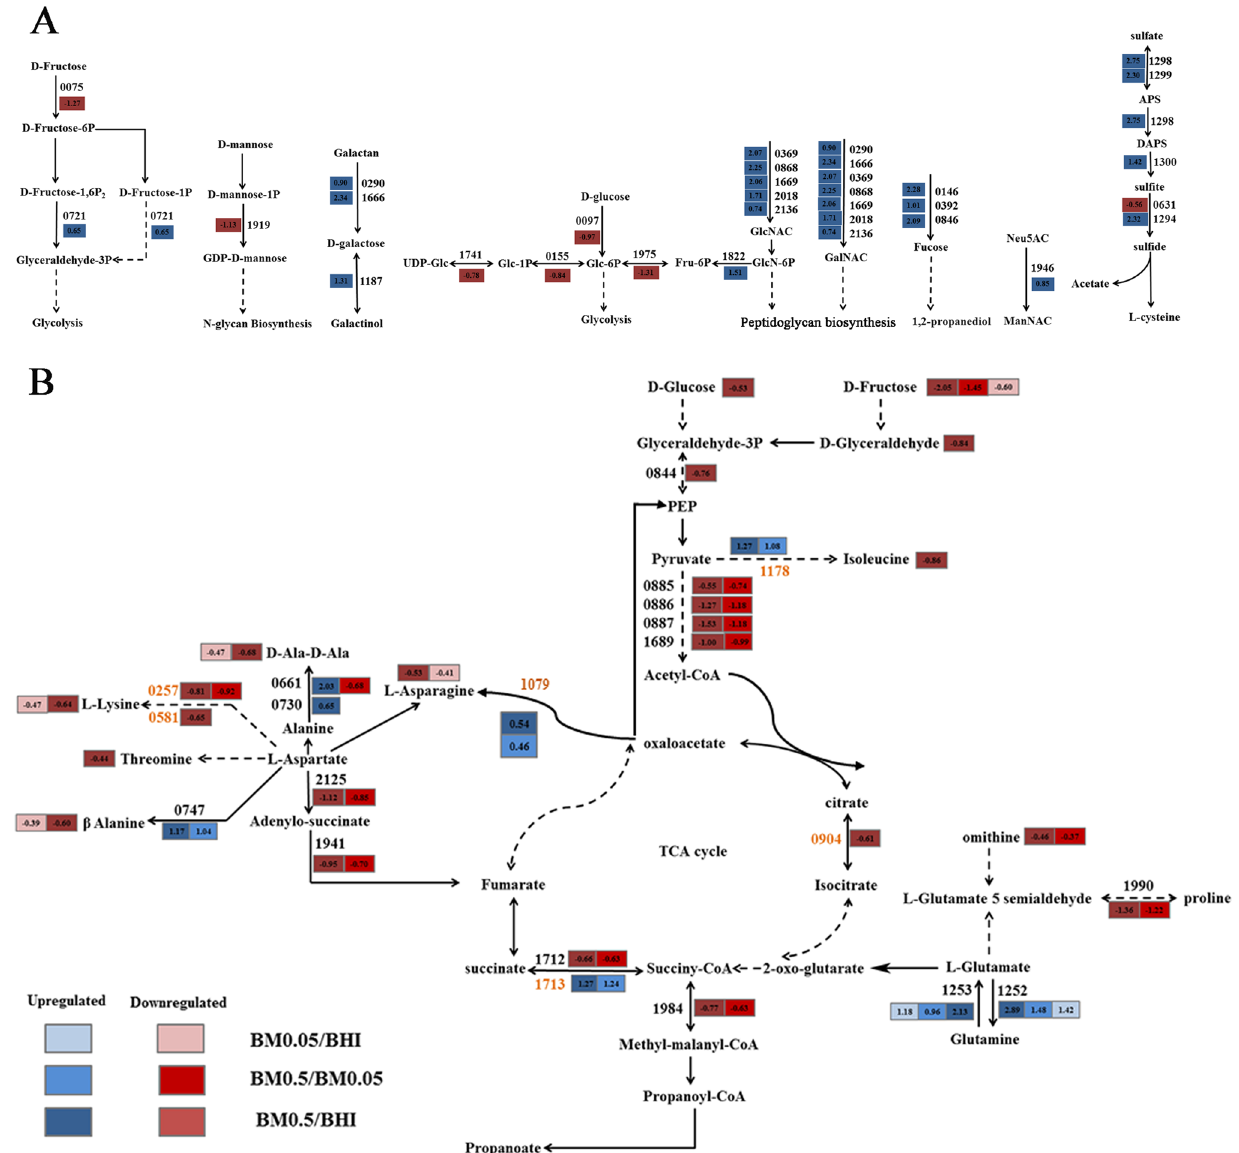
Figure 8. Proposed mechanism of mucin regulating the growth of A. muciniphila. ( A ) Pathways regulating the growth of A. muciniphila in BM0.5 group. ( B ) Pathway related to mucin-dependent metabolism in A. muciniphila . The proposed metabolic pathways were based on Swiss-Prot and KEGG databases. Blue boxes represent upregulated genes or metabolites, and red boxes represent downregulated genes or metabolites. The figures in the boxes represent log 2 fold_changes between BM0.5 and BHI groups. The number on arrows represents the number of DEGs in KEGG database (For example: 0146 represent amu: Amuc_0146). Straight arrows indicate the direct effect between two substances. Dotted arrows indicate multiple steps between two substances. The proposed metabolic pathways are based on KEGG database (http:// www. kegg. jp/ kegg/ kegg1.